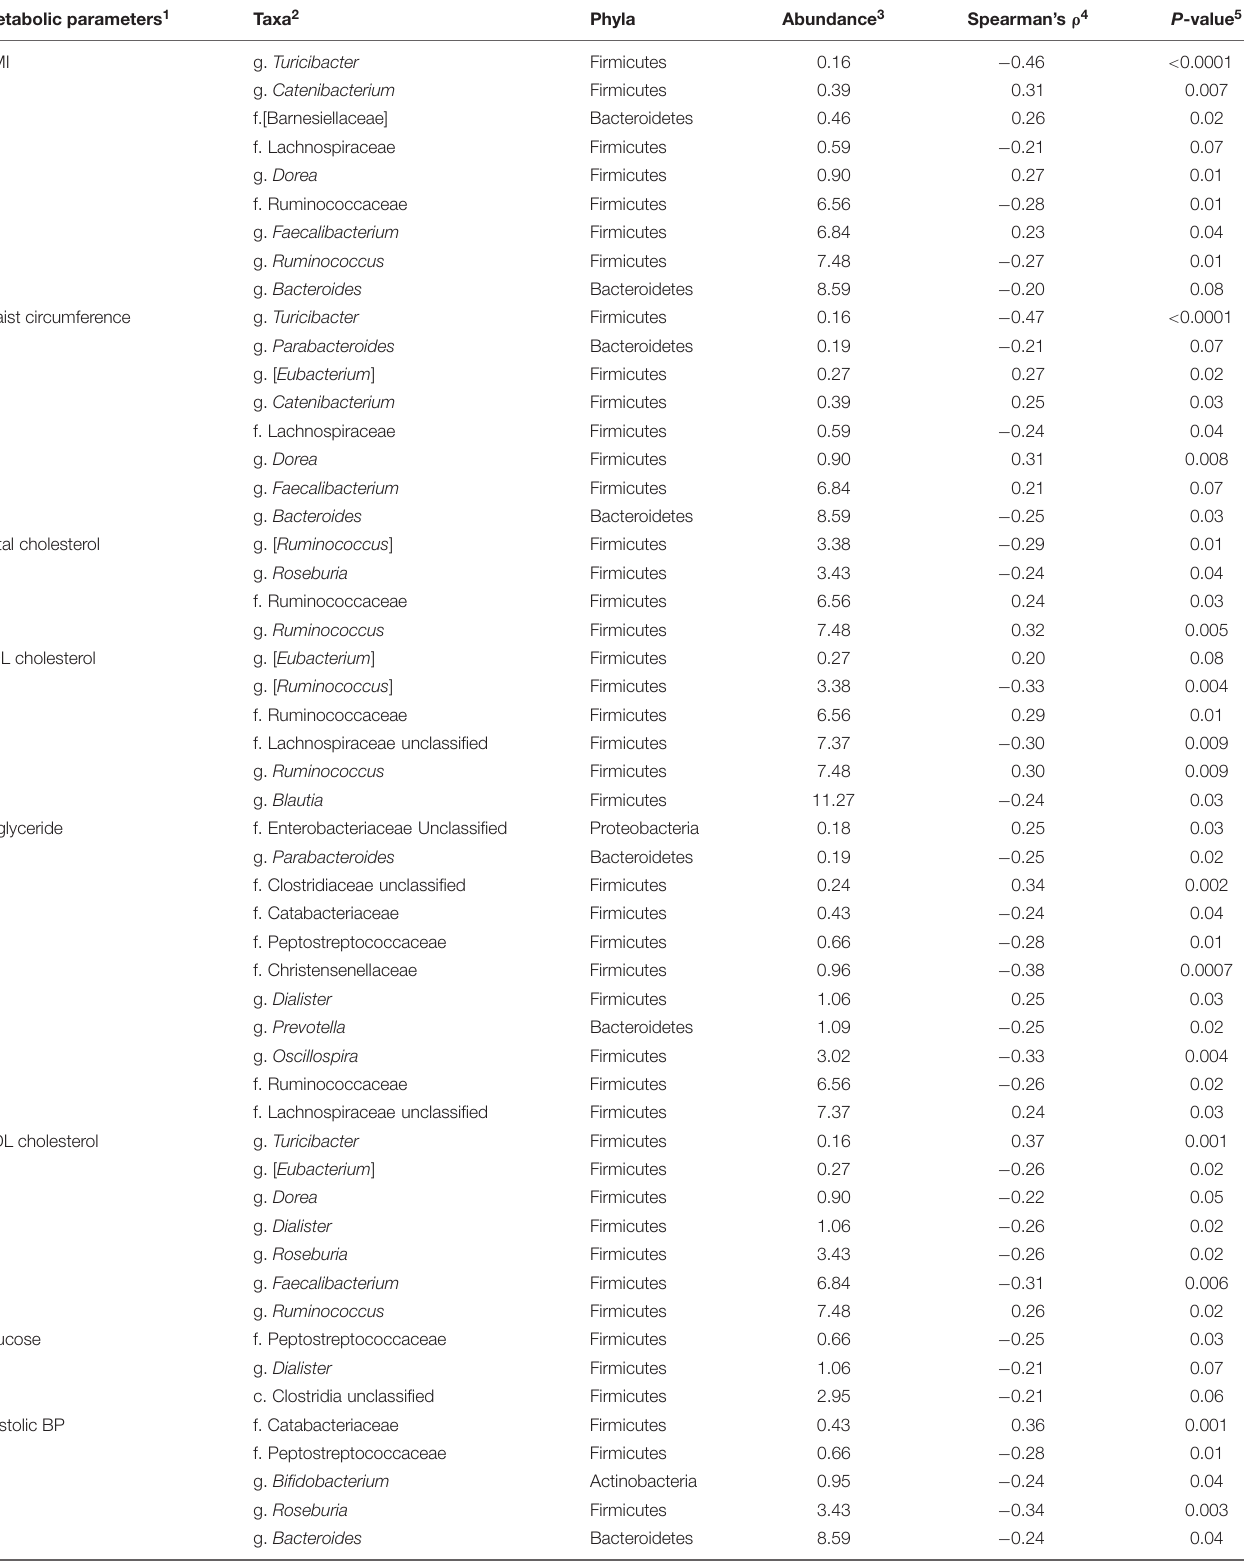
TABLE 4 | Non-parametric correlations between metabolic parameters and bacterial taxa. Metabolic parameters